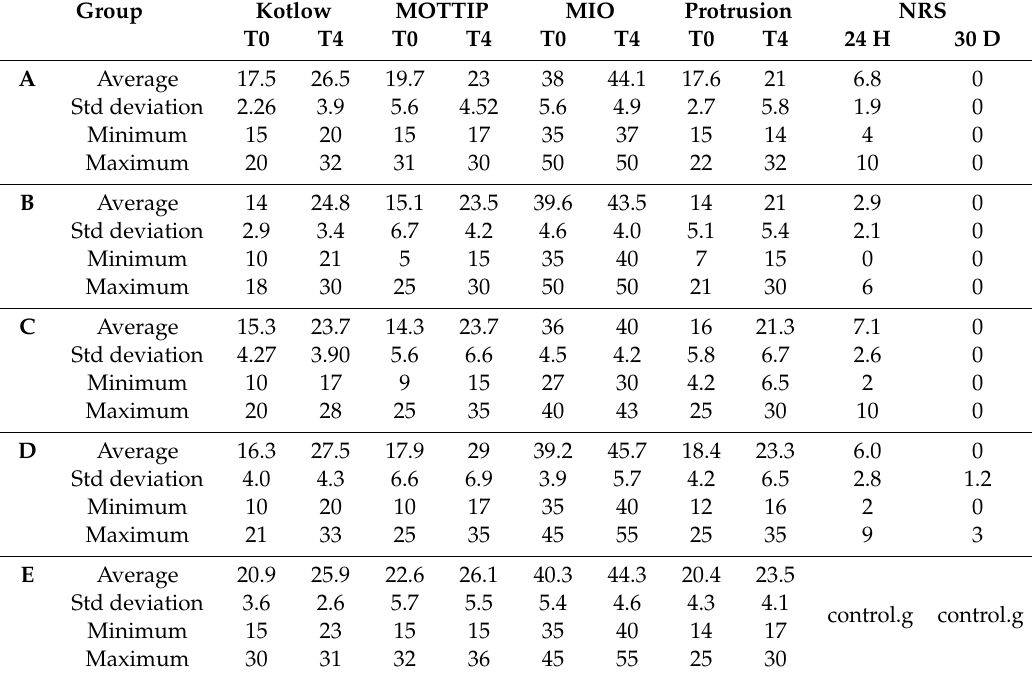
Table 3. Quantitative results of parameters and NRS